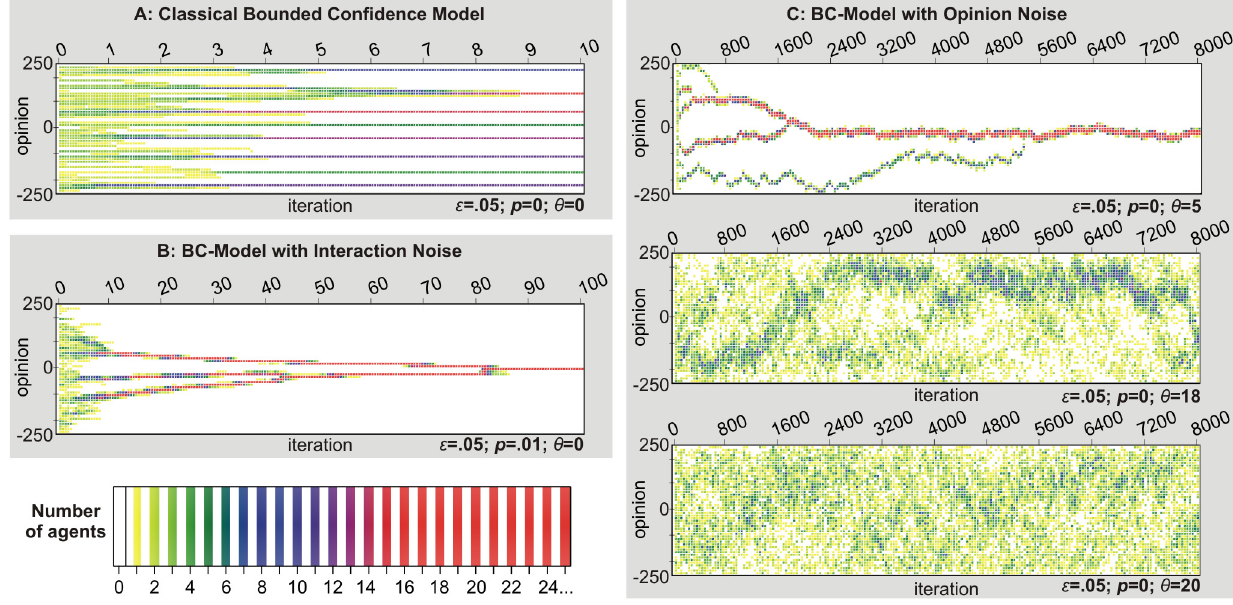
Figure 1. Opinion dynamics produced by the bounded confidence (BC) model [ 33 ] with and without noise. Populations consist of N ~ 100 agents. Opinions vary between 2 250 and 250. Initial opinions are uniformly distributed. For visualization, the opinion scale is divided into 50 bins of equal size. Color coding indicates the relative frequency of agents in each bin. (A) Dynamics of the BC-model without noise [33] over 10 iterations (Each iteration consists of N simulation events t .). At each simulation event, one agent’s opinion is replaced by the average opinion of those other agents who hold opinions o j ( t ) within the focal agent’s confidence interval ( o i ( t ) { E ƒ o j ( t ) ƒ o i ( t ) z E ). For E ~ 0 : 05 , one finds several homogeneous clusters, which stabilize when the distance between all clusters exceeds the confidence threshold E . (B) Computer simulation of the same BC-model, but considering interaction noise . Agents that would otherwise not have been influential, now influence the focal agent’s opinion with a probability of p ~ 0 : 01 . This small noise is sufficient to eventually generate monoculture. (C) Simulation of the BC-model with opinion noise. After each opinion update, a random value drawn from a normal distribution with an average of zero and a standard deviation of h (abbreviated by N (0, h ) ) is added to the opinion. For weak opinion noise ( h ~ 5 ), one cluster is formed, which carries out a random walk on the opinion scale. When the opinion noise is significantly increased ( h ~ 18 ), there is still one big cluster, but many separated agents exist as well (cf. Fig. 4). With even stronger opinion noise ( h ~ 20 ), the opinion distribution becomes completely